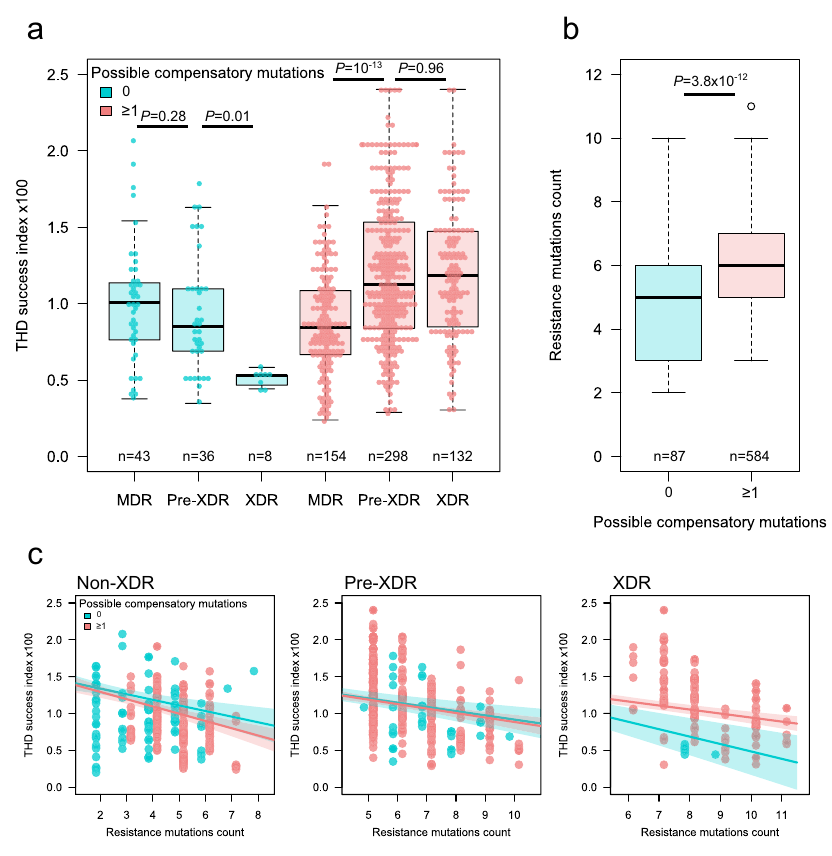
Fig. 5 | Compensatory mutations in fl uence the epidemic success of drug- resistant variants of W148 M. tuberculosis . Whole genome sequences of 671 isolateswereusedtoinferthepresenceofpossiblecompensatorymutationsandto computeindicesofepidemicsuccessusingtheTHDmethodwitha10ytimescale. a Evolution of success indices with resistance status (MDR, and pre-XDR, XDR according to de fi nitions in place in 2020) in isolates with and without possible compensatory mutations. The median success index decreased with resistance status in isolates lacking compensatory mutations and increased in isolates har- boring these mutations. Solid bars indicate the median, boxes represent the inter quartilerange(IQR),whiskersextendto1.5×IQR. b Theno.ofresistance-conferring